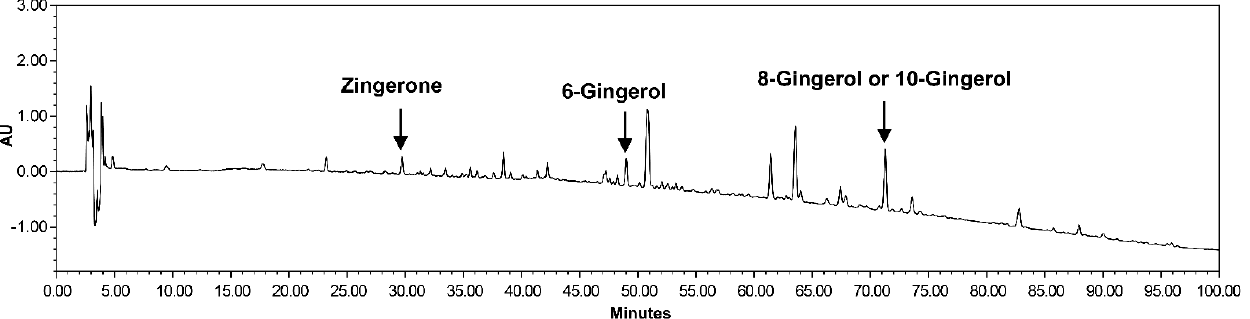
Figure 1. High-performance liquid chromatography of extracts from Zingiberis Processum Rhizoma . Identities of chromatogram peaks confirmed through their respective absorbance spectra obtained with the photodiode array 200 detector.